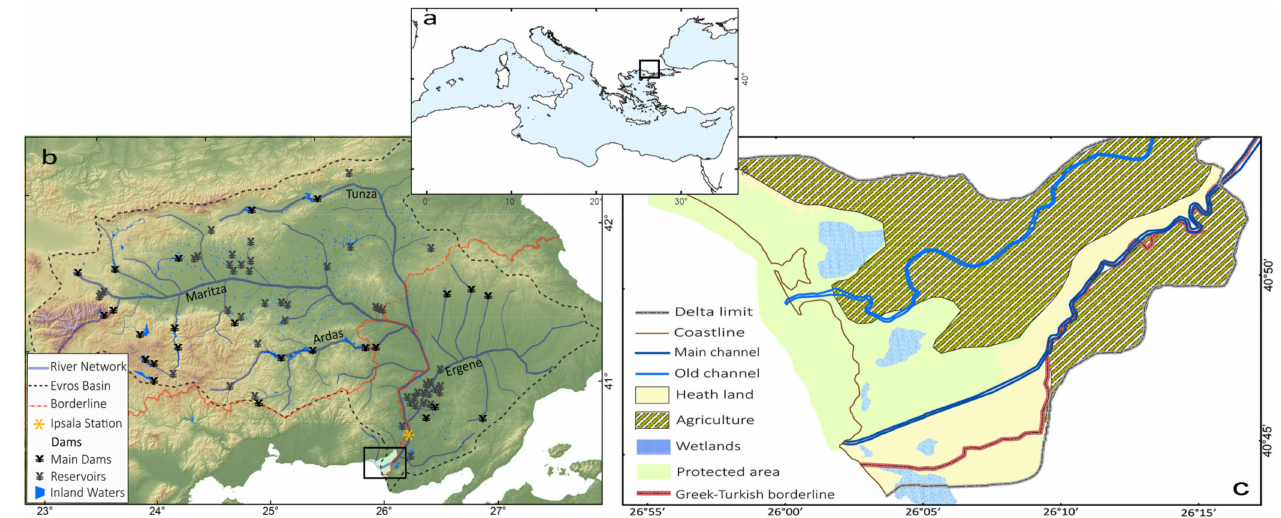
Figure 1. ( a ) The Mediterranean region—the black rectangle indicates the Evros river basin; ( b ) the Evros river basin terrain model—the black rectangle indicates the delta of Evros river; and ( c ) the Evros river deltaic area land